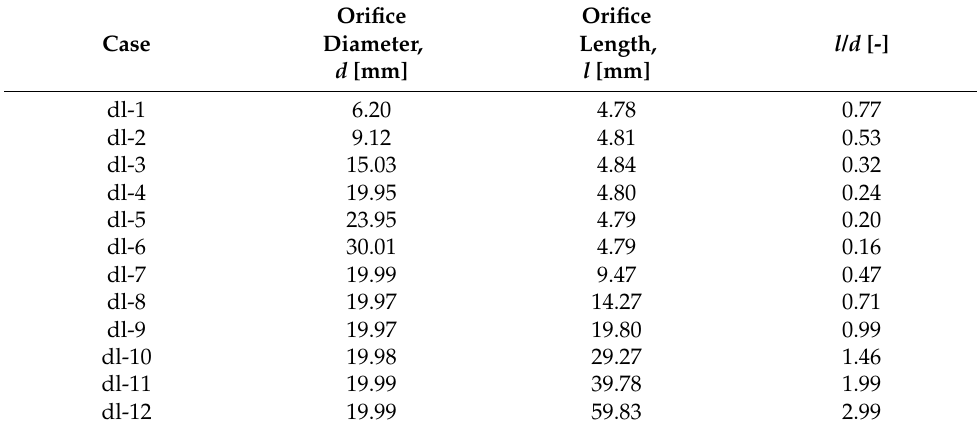
Table 2. Dimensions of the available front plates with orifices.